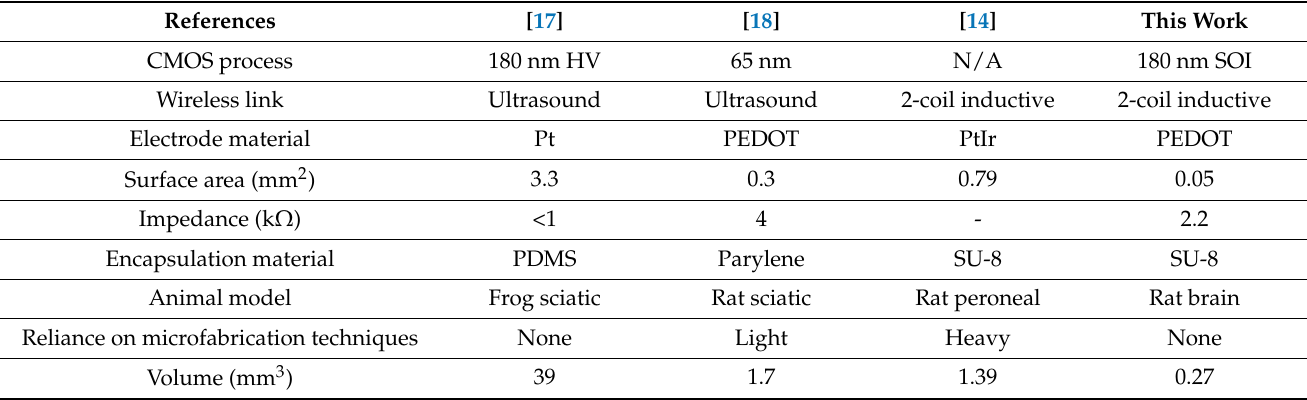
Table 1. Comparison table of the recent epicortical, stimulating, wireless microdevices.